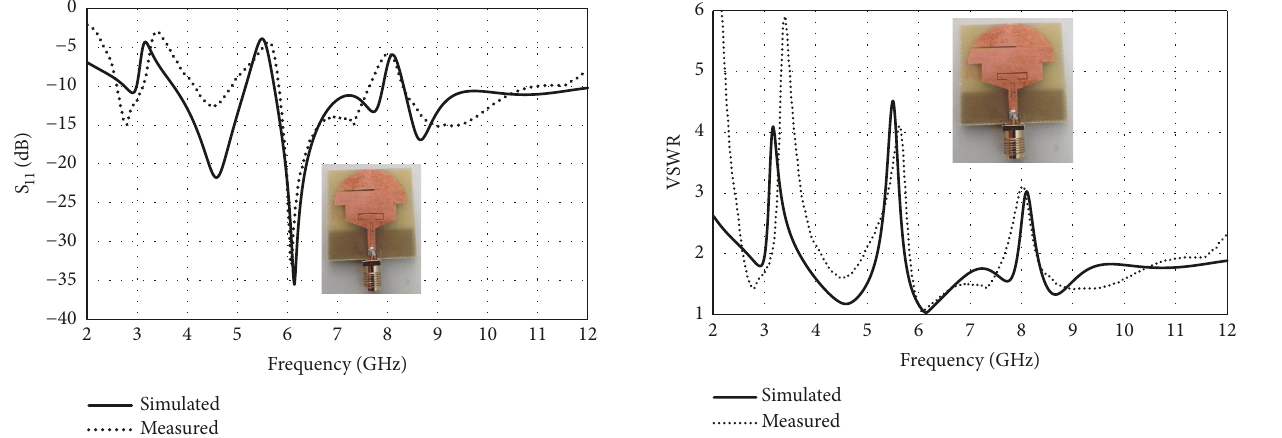
Figure 13: Measured and simulated S 11 (dB) of the proposed UWB antenna.